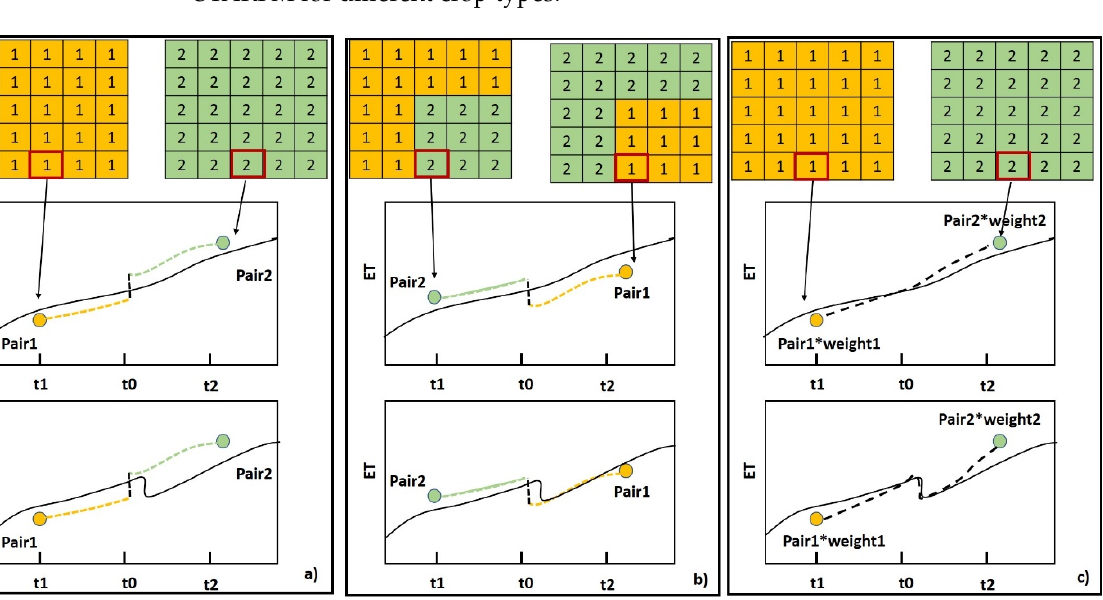
Figure 2. Schematic diagram of different STARFM modes operating under consistent change and abrupt change conditions. On the top of each panel is an example of pair information at the pixel level. a) One-pair STARFM; b) two-pair STARFM; c) proposed dual-pair STARFM.